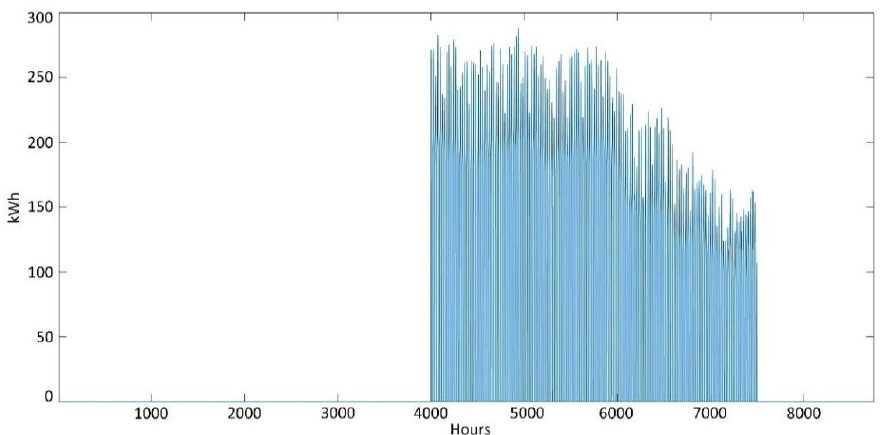
Figure 9. Fan coil hourly cooling energy trend.